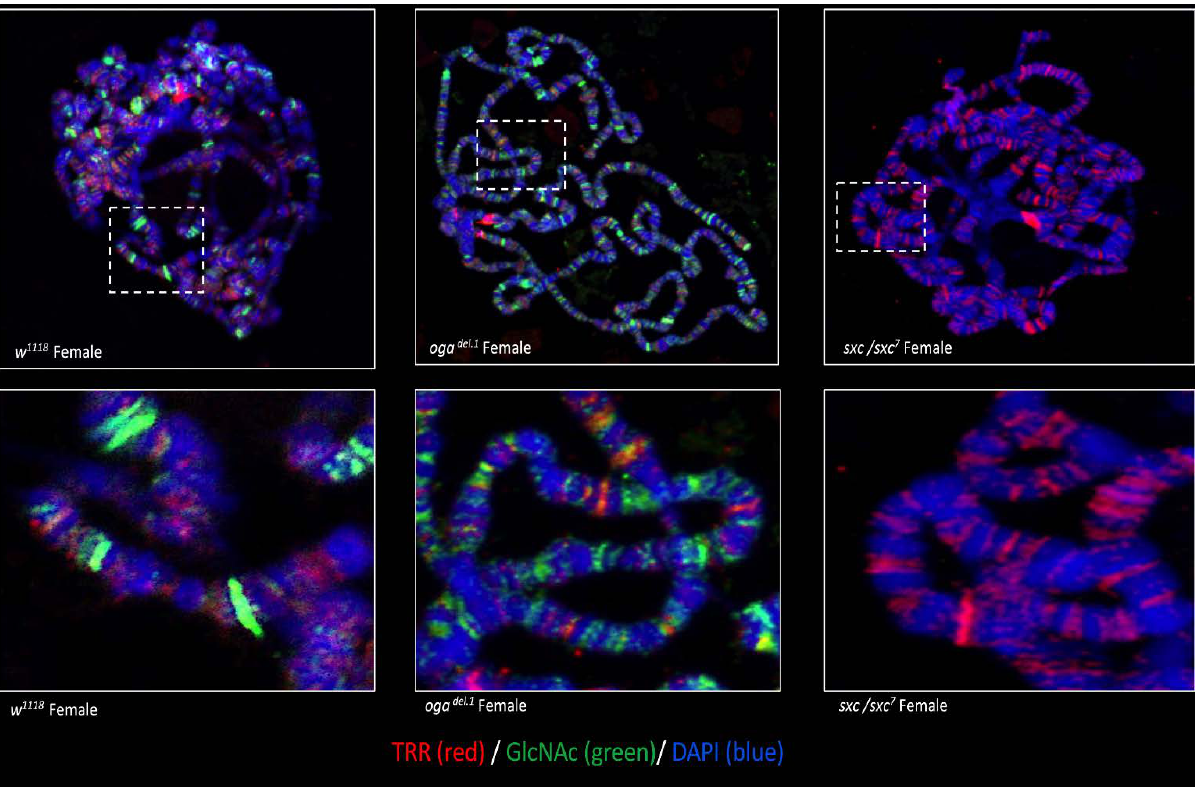
Figure 5. Trithorax-related (TRR) colocalizes with O -GlcNAc in certain genomic regions on the polytene chromosomes. Polytene chromosomes prepared from the third instar larvae of wild type ( w 1118 ), oga mutants ( oga del.1 ) and ogt mutant ( sxc 1 /sxc 7 ) were stained for TRR (red), O -GlcNAc (green), and DAPI (DNA). TRR co-stained with O -GlcNAc on certain genomic regions. Polytenes from sxc 1 /sxc 7 were used as a negative control for O-GlcNAc staining.